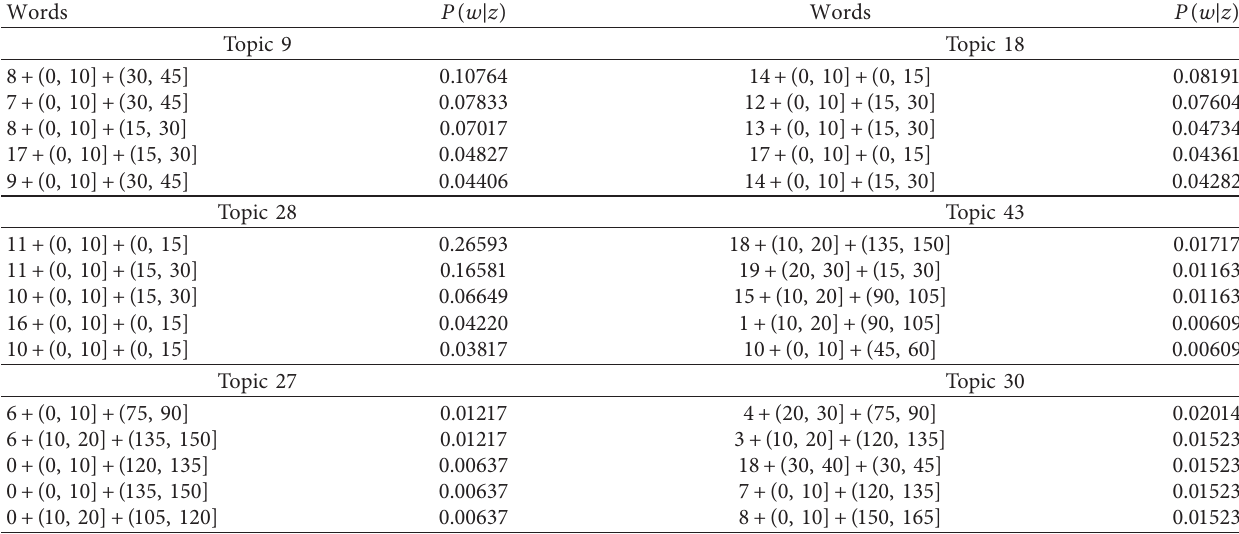
Table 4: Examples of the discovered interesting mobility